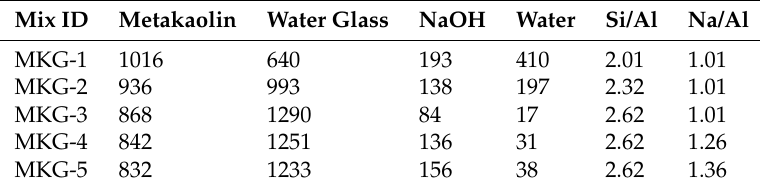
Table 2. Mix proportions of the metakaolin-based geopolymer (MKG)